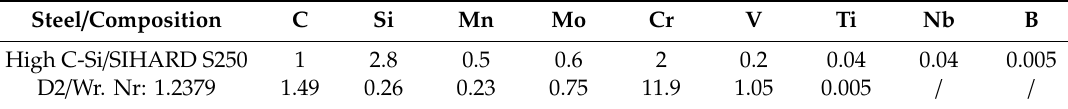
Table 1. Nominal compositions of characterized steels (in wt.%).